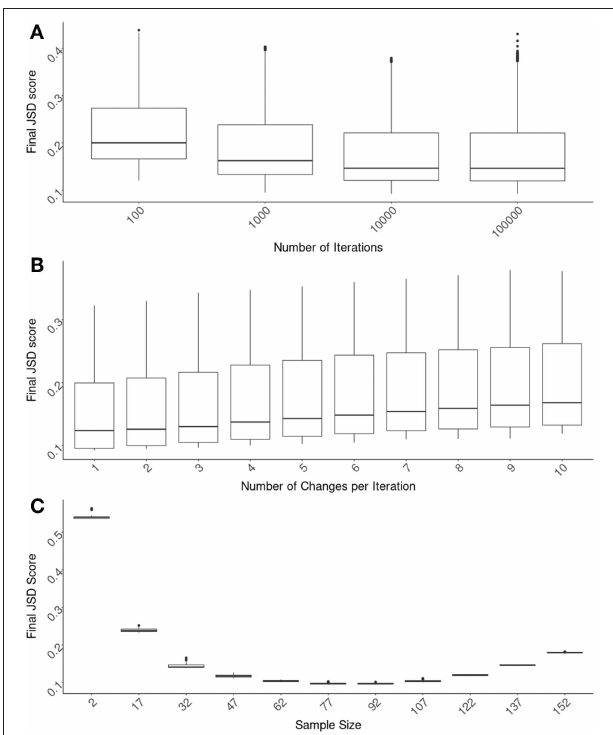
FIGURE 2 | Optimizing SampPick’s input parameters. The JSD score was calculated for 100 repetitions for each combination of: a sample size from 2–157, a number of iterations from 100 to 100,000, and a number of substitutions per iteration from 1 to 10. (A) The number of iterations for all test were compared and there is a clear decrease of scores as iterations increase. The decrease in JSD scores appears to diminish at 10,000 iterations. (B) Looking only at the tests with 10,000 iterations, the number of substitutions per iteration was examined. Simply making one substitution per iteration returned the lowest scores. (C) Looking at the tests with 10,000 iterations and 1 substitution per iteration, the JSD scores decrease as sample size increases. At a sample size of 82, the JSD score increases as sample size